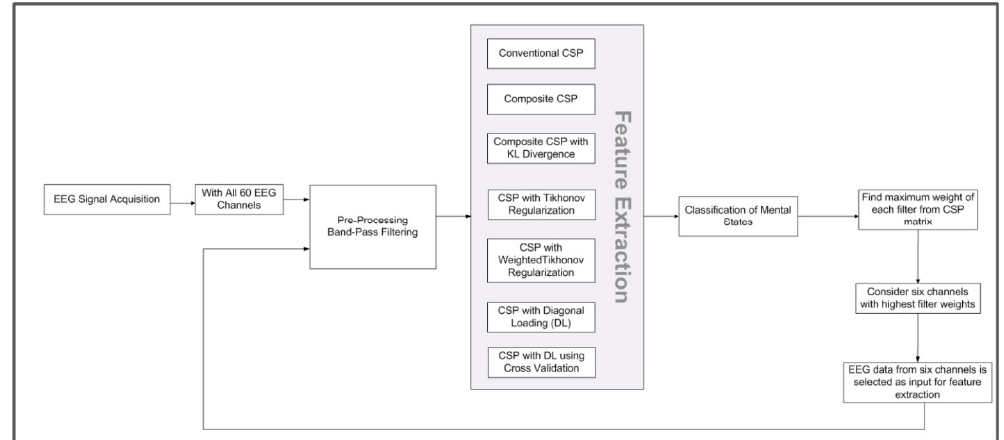
Figure 6. Methodology to find the reduced number of electroencephalography (EEG) channels based on CSP filter weights